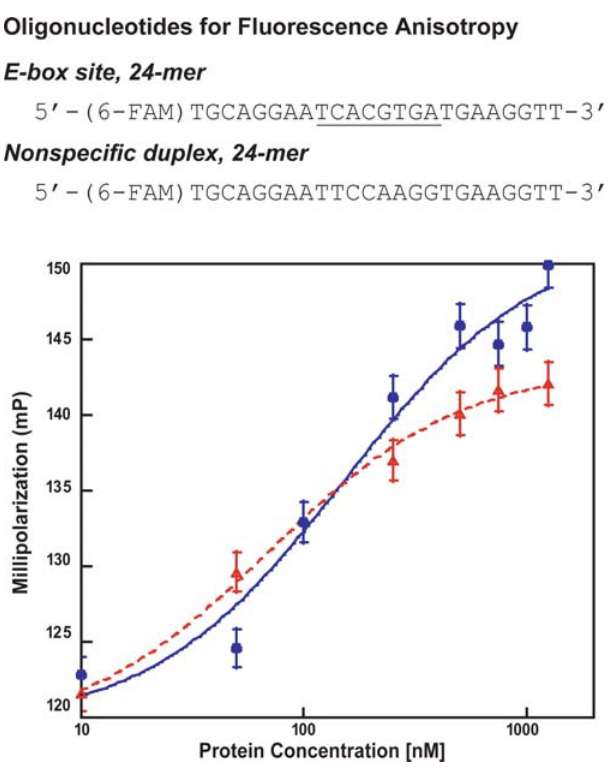
Figure 5. Thermodynamic fluorescence anisotropy titrations. (top) DNA duplexes used in fluorescence anisotropy titrations. ‘‘6-FAM’’ is 6-carboxyfluorescein, and the core E-box is underlined. (bottom) Representative equilibrium binding isotherms for ArntbHLH ( n , dashed red line) and ArntbHLH-C/EBP ( N , solid blue line) targeting the E-box. Each isotherm was obtained from an individual titration. Buffer B was used for both titrations. 1.25 m M protein monomer is the highest concentration for which protein solubility is reliably maintained.